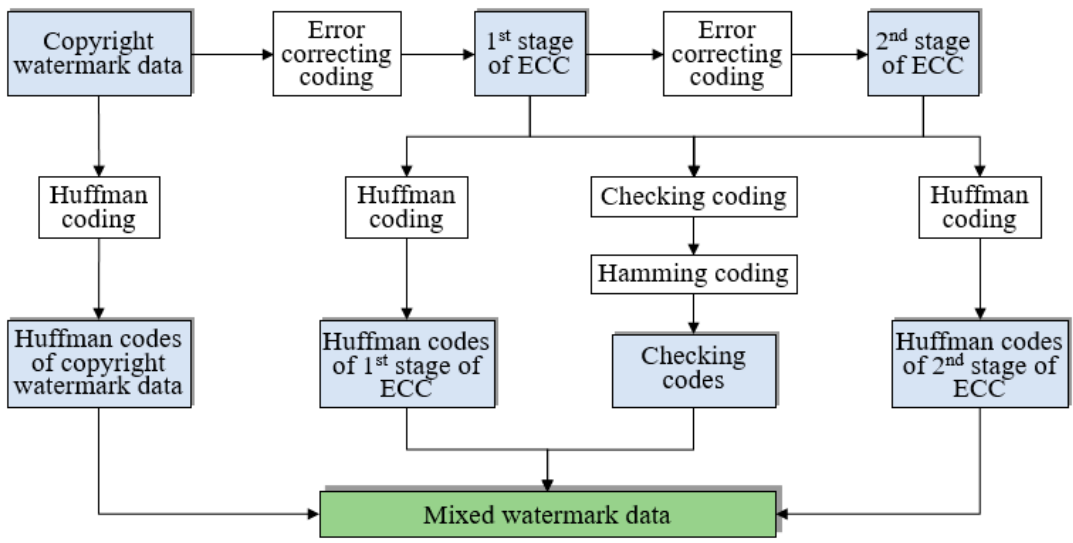
Figure 1. The basic framework of mixed watermark data